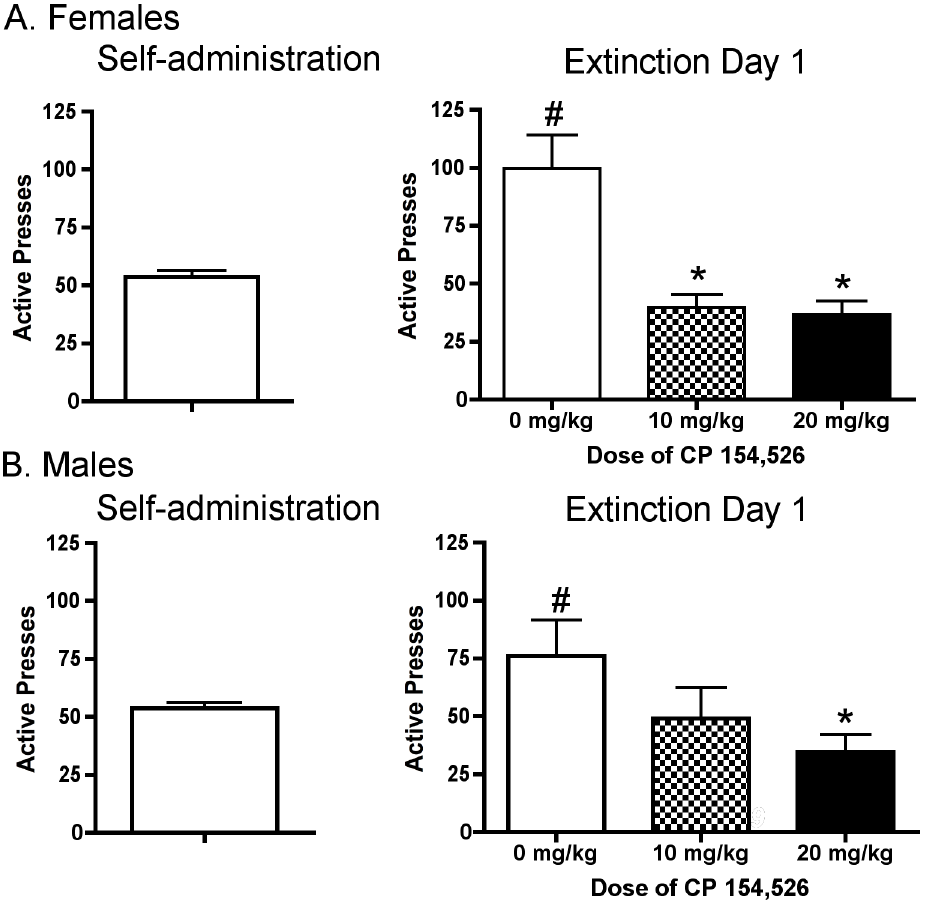
Fig 1. Effects of CP on ED1 Responding. Responding for cocaine was increased during initial abstinence (ED1) compared to self-administration responding in female and male rats. Pretreatment with the CRF 1 receptor antagonist (CP) attenuated ED1 responding for cocaine compared to vehicle to a greater degree in female compared to male rats. # p < 0.05 compared to self-administration; * p < 0.05 versus CP vehicle on